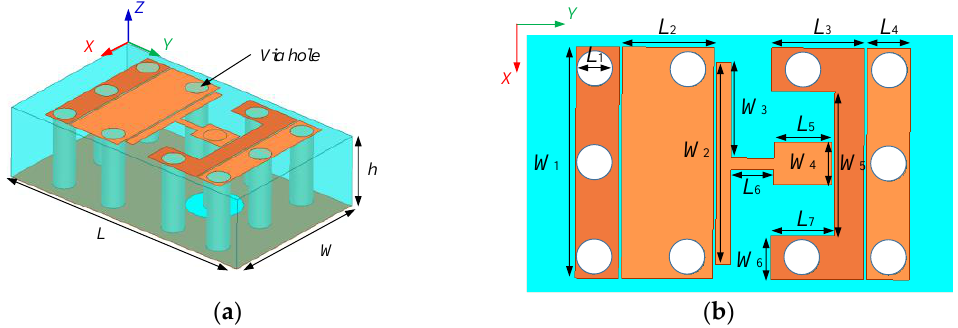
Figure 12. Structure diagram of feed antenna: ( a ) three-dimensional structure diagram; ( b ) structure diagram of radiation patch. Table 2. Size of feed antenna.